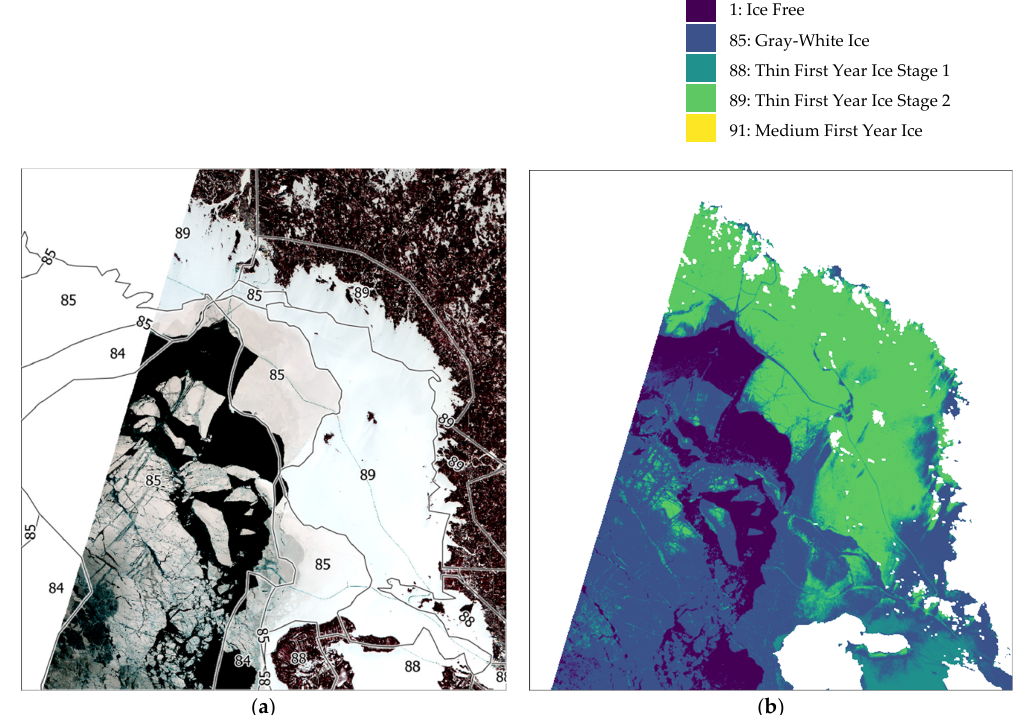
Figure 16. ( a ) Landsat-8 false color for 16 February 2021; BSH ice chart for 16 February 2021; ( b ) ICESOD classification.